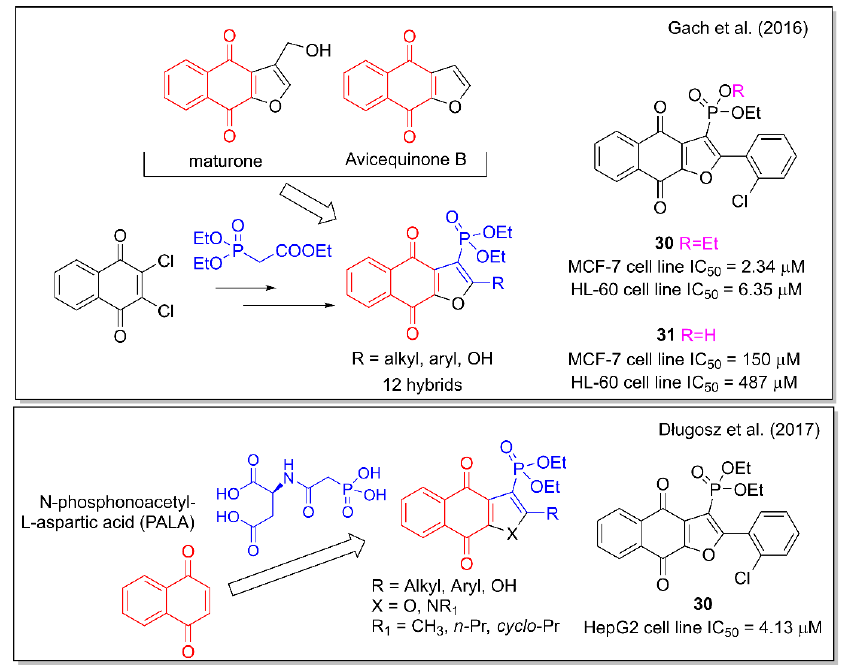
Figure 12. Naphthofurandione – phosphonate hybrids as reported by Janecka and